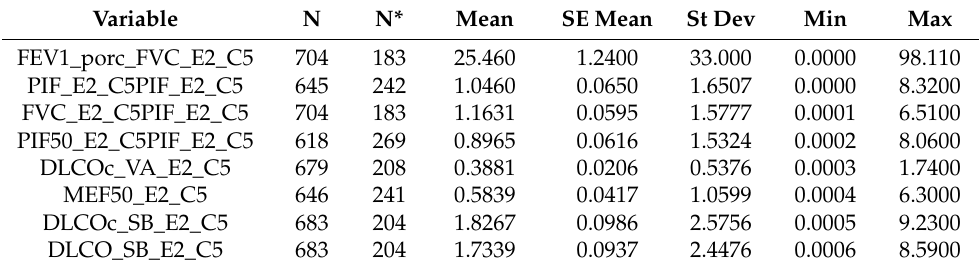
Table 1. Descriptive statistical study of variables for the subcategory pulmonary function testing (PFT). The number of instances is 887, N representing the number of instances with known data and N ∗ the number of instances with missing data ( N + N ∗ = 887). SE Mean and StDev are the mean deviation and standard deviation of the feature,